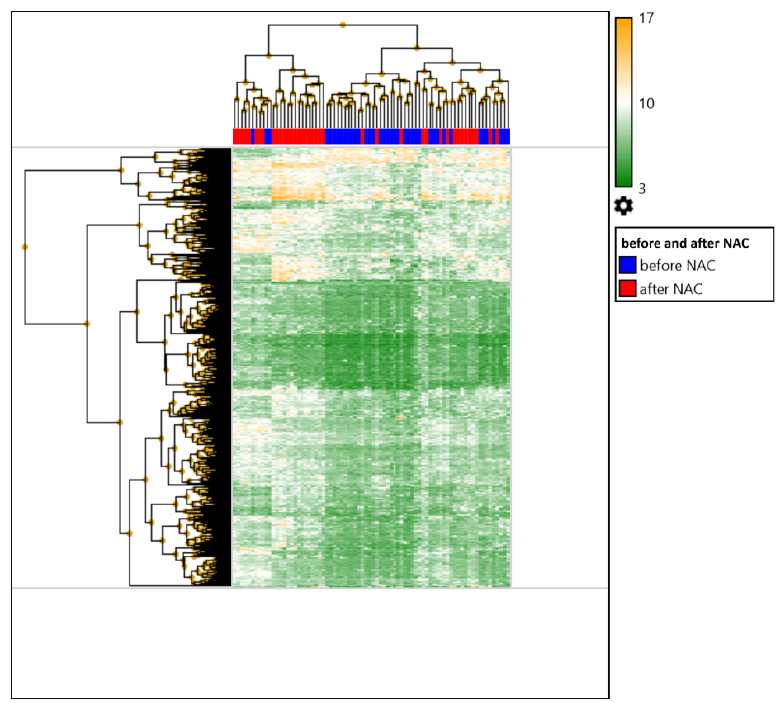
Figure 1. Heat map of DEG in tumors of BC patients before and after NAC. Clustering of data before treatment is shown in blue: by patients (upper side of the heat map), by DEGs (left side of the heat map), clustering after NAC is shown in red: by patients (upper side of the heat map), by DEGs (left side of the heat map).